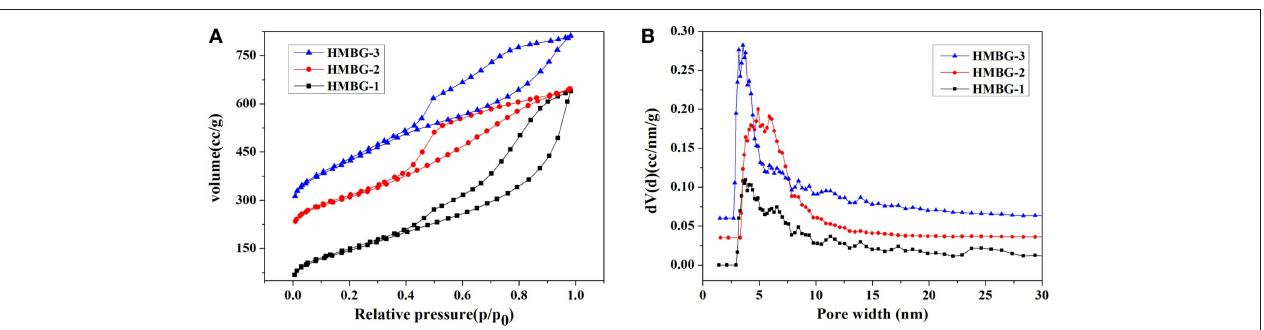
FIGURE 1 | SEM and TEM images of HMBG-1 (a) , HMBG-2 (b) , and HMBG-3 (c) .